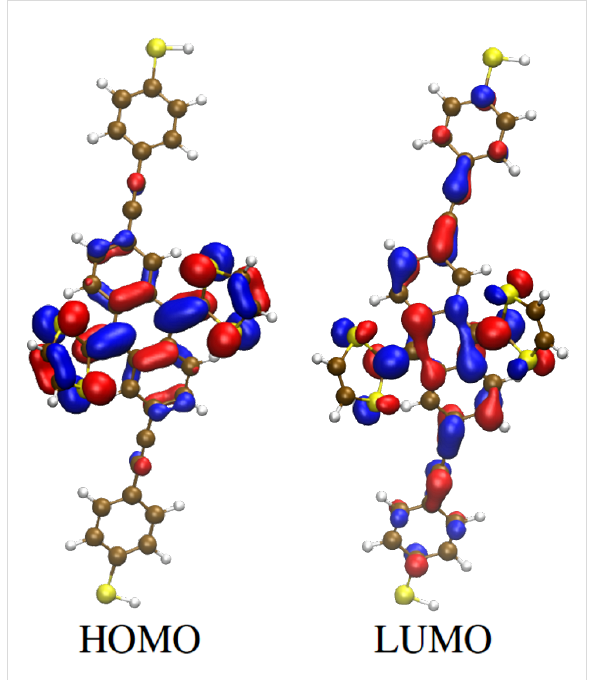
Figure 7: Frontier orbitals of compound 5 in the gas phase.